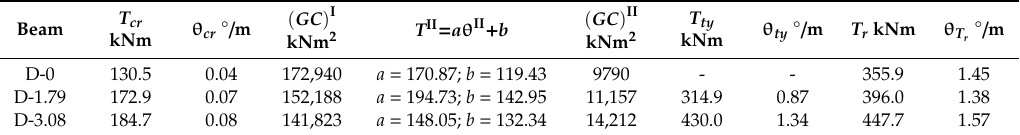
Table 3. Properties of T – θ m